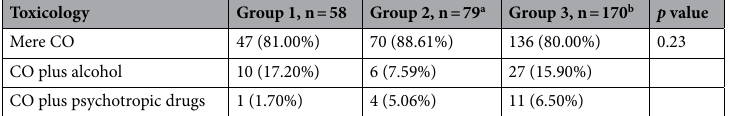
Table 4. Distribution of CO poisoning deaths by toxicology with inclusion of fire-related cases (n = 307). a 1 Case with combined alcohol and psychotropic drugs were repeatedly allocated to each category. b 4 Cases with combined alcohol and psychotropic drugs were repeatedly allocated to each category.